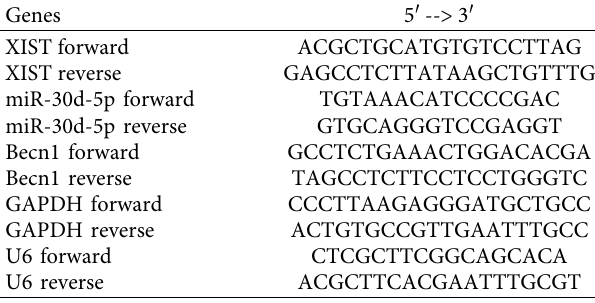
Table 2: Primers used in this